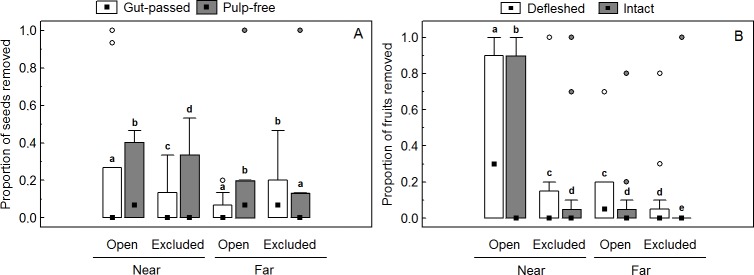
Miconia irwinii diaspore removal by the ground-dwelling fauna in campo rupestre vegetation.(A) Effects of gut passage (gut-passed vs. pulp-free seeds), distance from conspecific (near vs. far) and vertebrate exclosure (open vs. excluded) on the proportion of Miconia irwinii seeds removed. (B) Effects of fruit handling (partially defleshed vs. intact fruits), distance from conspecific and vertebrate exclosure on the proportion of Miconia irwinii fruits removed. Squares represent medians, boxes represent 25–75% percentiles, whiskers represent non-outlier ranges and circles show the outliers. Distinct letters denote significant differences among treatments.